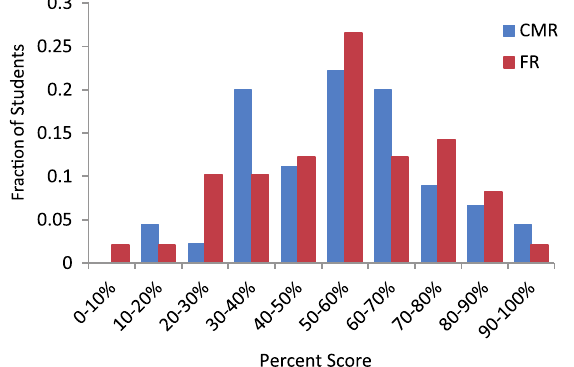
FIG. 3. Distributions of scores on the CMR ( N ¼ 45 ) and FR ( N ¼ 49 ) CUE for the E&M 1 course at CU. There is no statistically significant difference between the distributions (student ’ s t test, p ¼ 0 . 9